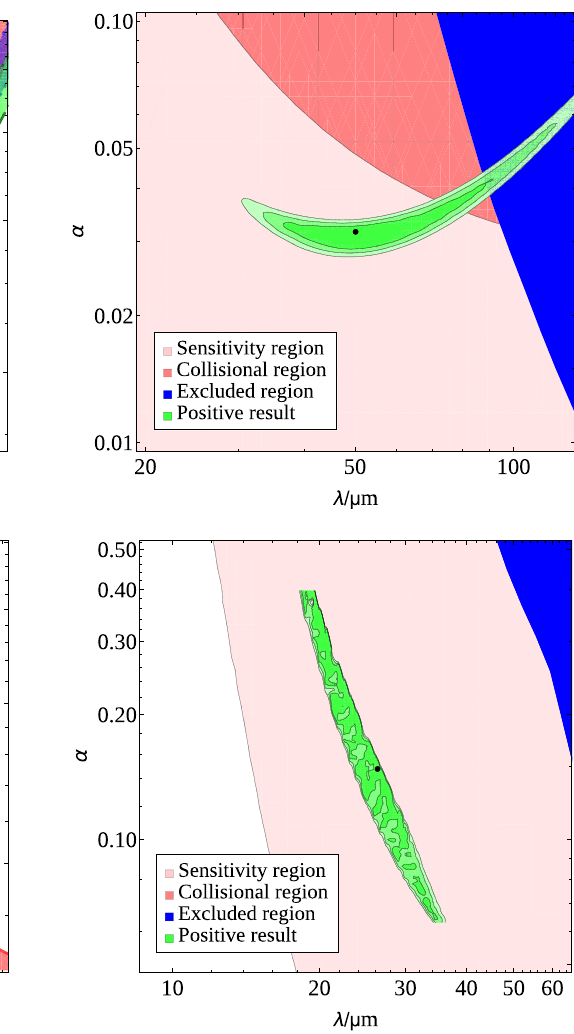
Left panels: 2 σ contours for χ 2 as defined in Eq. (27) for three different choices of the initial conditions (indicated in the legends). Right panels: 1 σ, 2 σ and 3 σ contours for χ 2 as defined in Eq. (27) for the combined fit of all three choices in the left panels. In the same plot, we also depict the presently excluded region (in blue) and the collisional region (dark